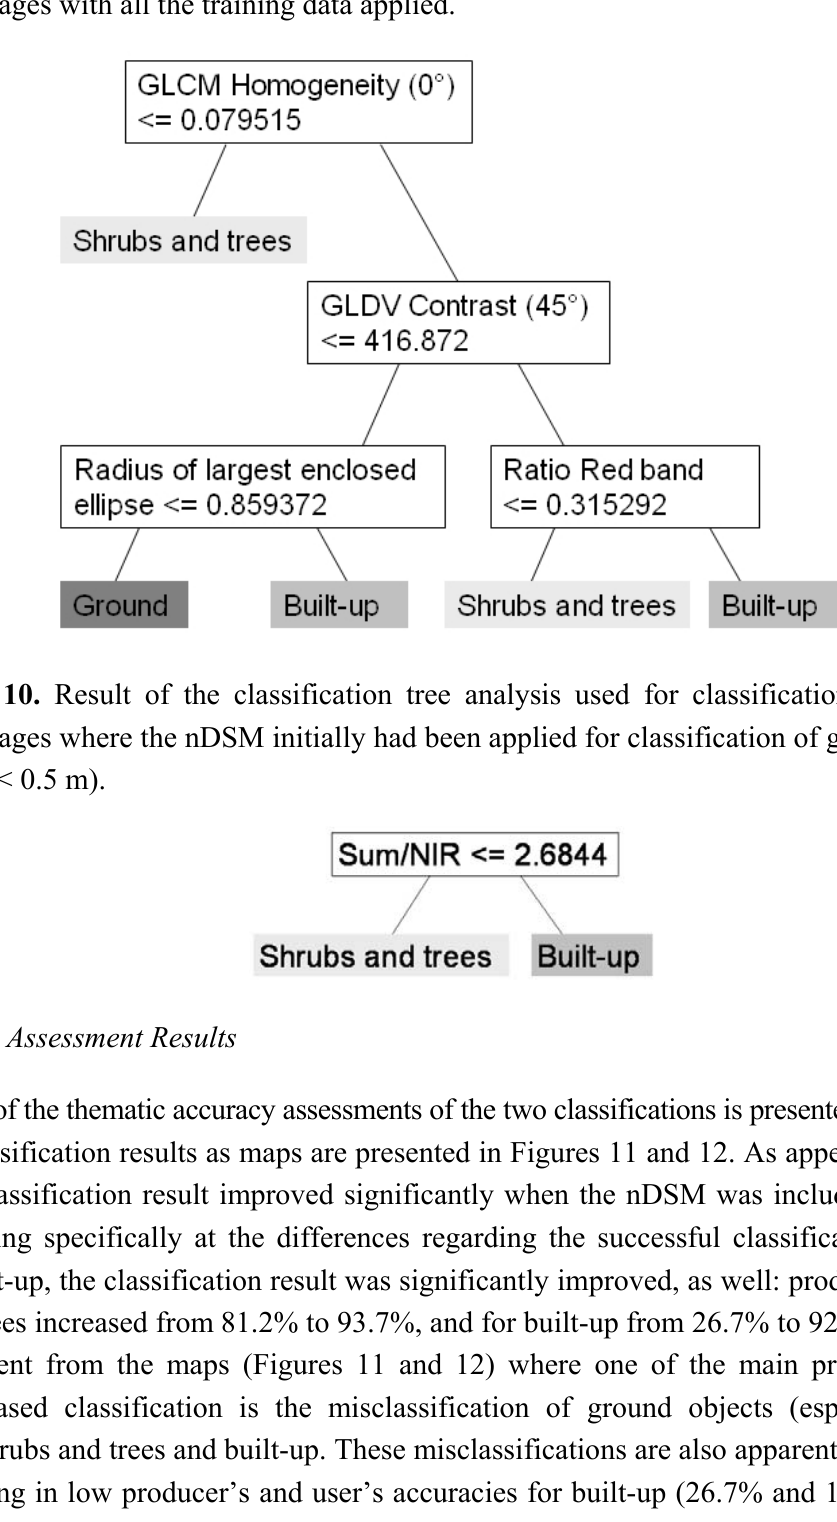
Figure 9. Result of the classification tree analysis used for classification of the CIR orthoimages with all the training data applied.